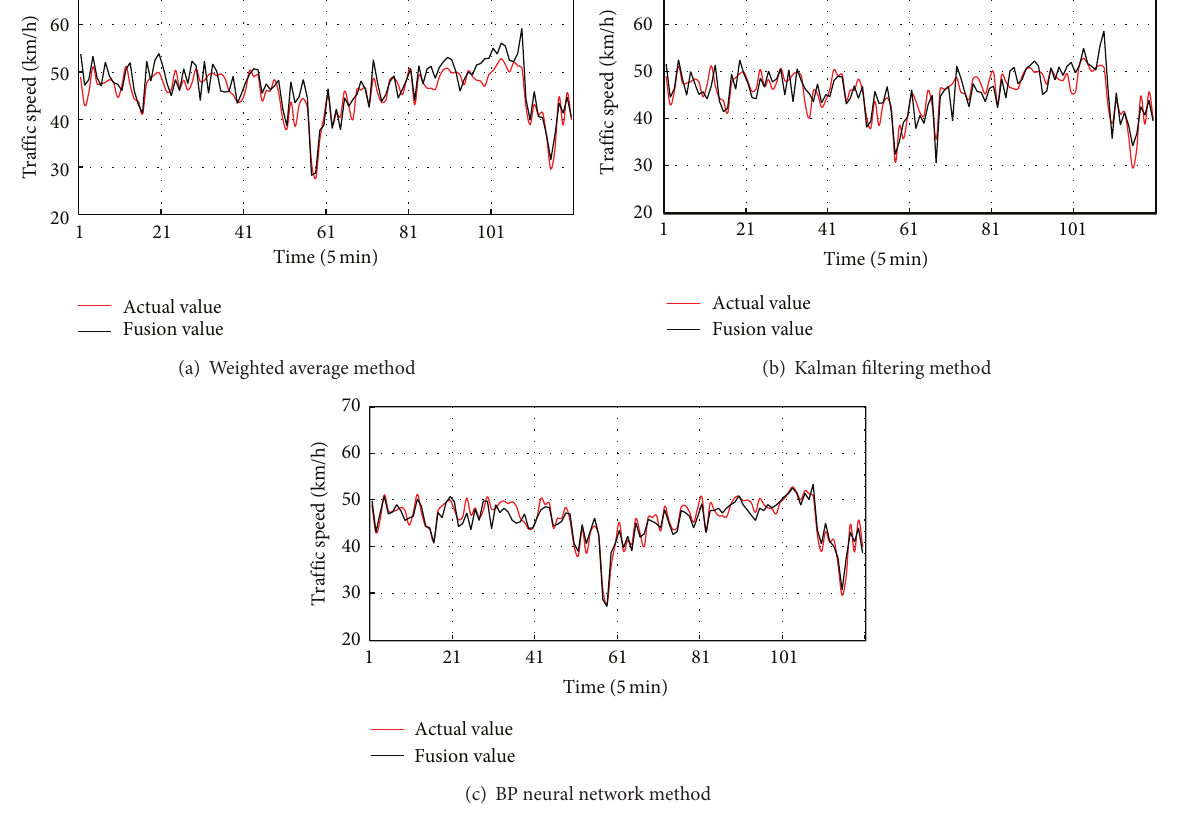
Figure 12: Results of the three methods.